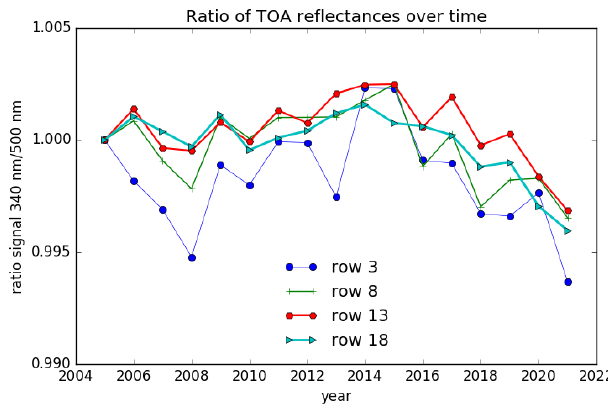
Figure 11. Time series of the ratio of measured TOA reflectance at 340 to 500nm, in UV2 and VIS, respectively.